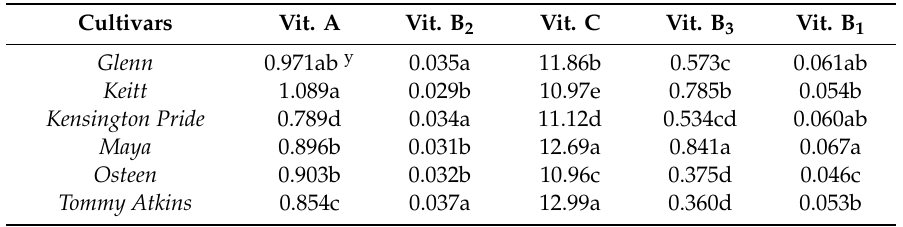
Table 6. Vitamin (mg 100 g − 1 ) of the six mango cultivars in trial. Vitamin A (Vit. A); riboflavin (Vit. B 2 ); ascorbic acid (Vit. C); niacin (Vit. B 3 ); thiamin (Vit. B 1